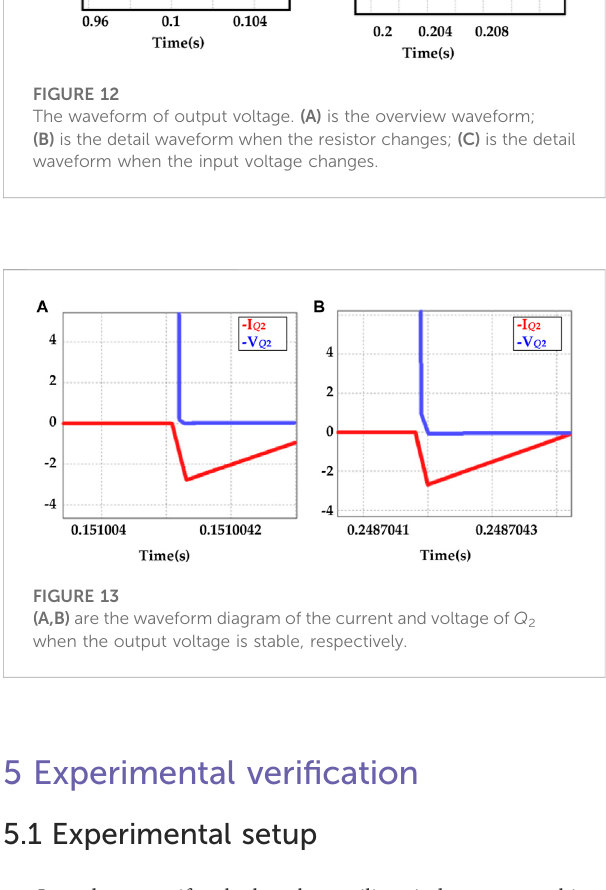
FIGURE 14 Photograph of the experimental setup.